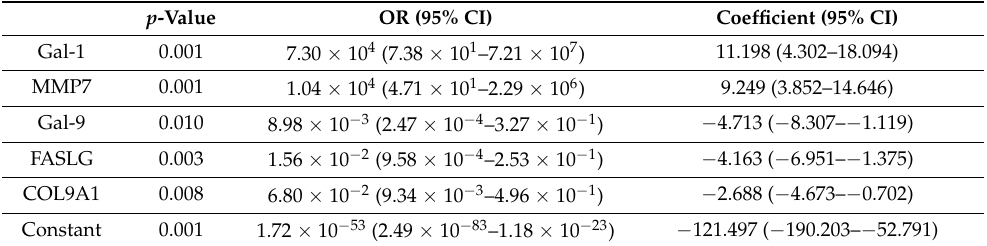
Table 10. Joint panel: result of the stepdown procedure applied to the saturated multivariate logistic regression model.